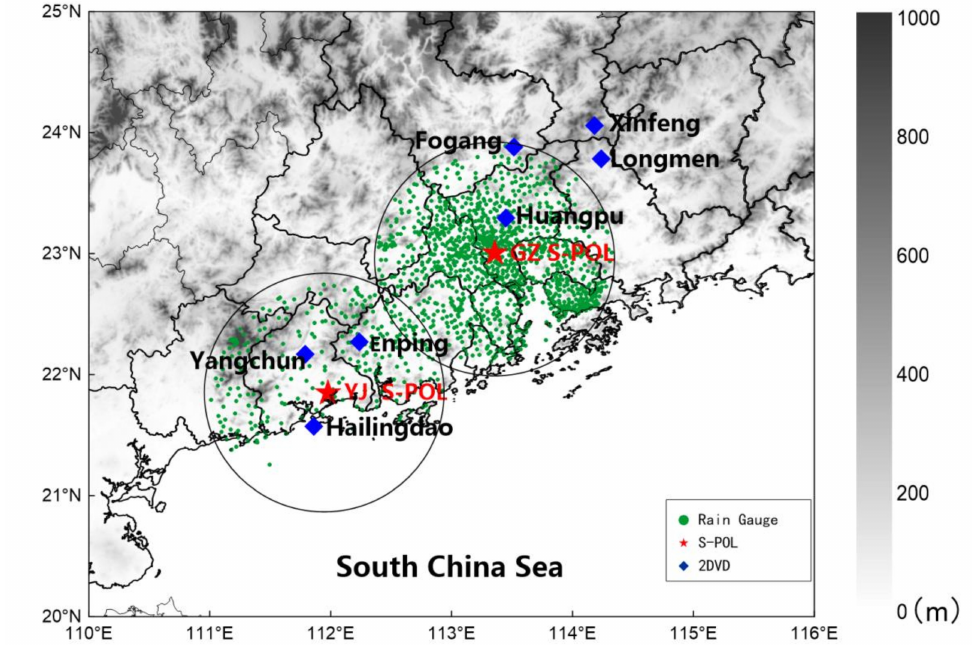
Figure 1. The red five-pointed stars represent the Locations of S-POL at Guangdong Province on the terrain heightmap. Green points show the location of the automatic weather stations within the area of radar coverage (5–100 km radius). The blue diamonds represent the 2DVD at Longmen Cloud Physics Field Experiment Base,